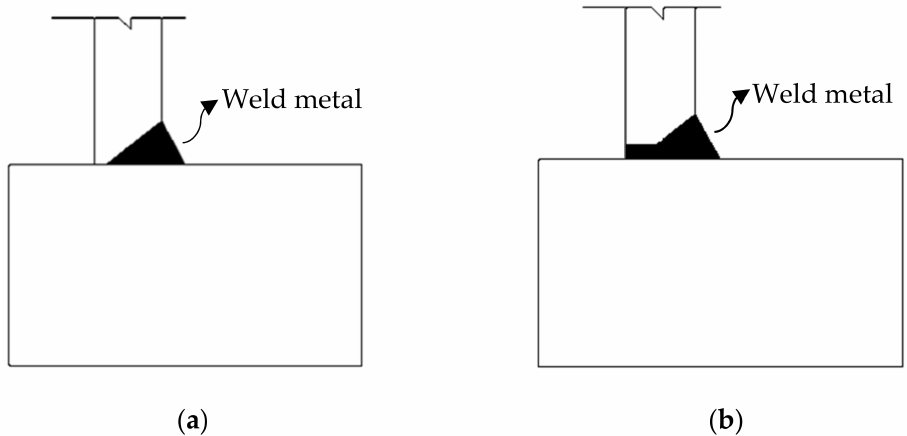
Figure 3. Penetration level of weld metal in fillet welded joints. ( a ) 75% penetration of weld metal; ( b ) 100% penetration of weld metal.